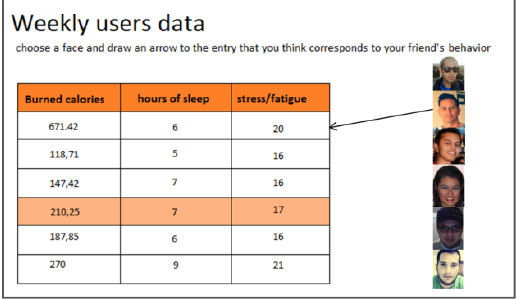
Figure 5 . Playing with Perception of the